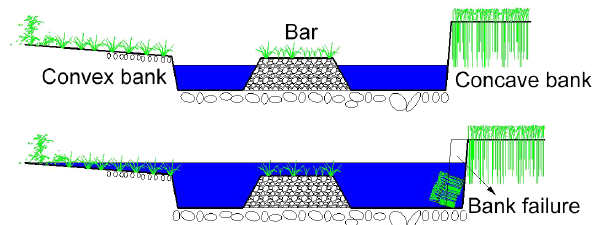
Figure 9. Sketch of submerged bend apex with a mid-channel bar in the Lanmucuo